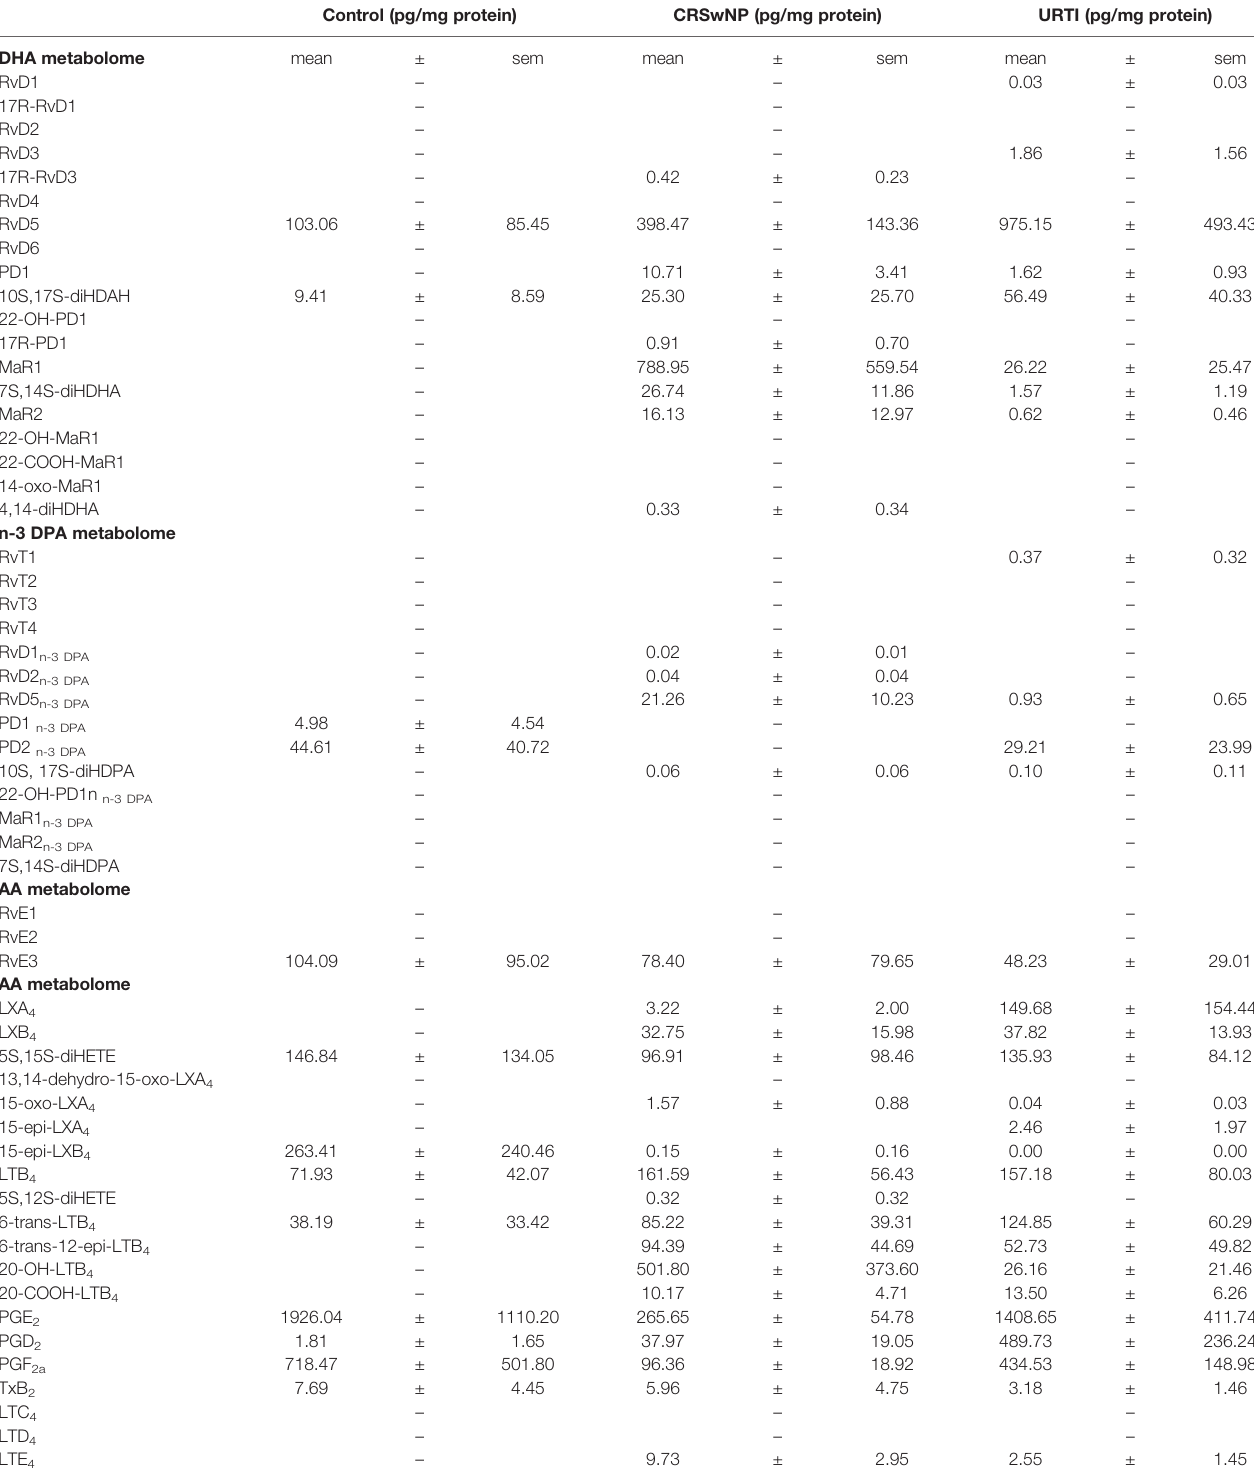
TABLE 3 | Lipid mediator pro fi les from nasal